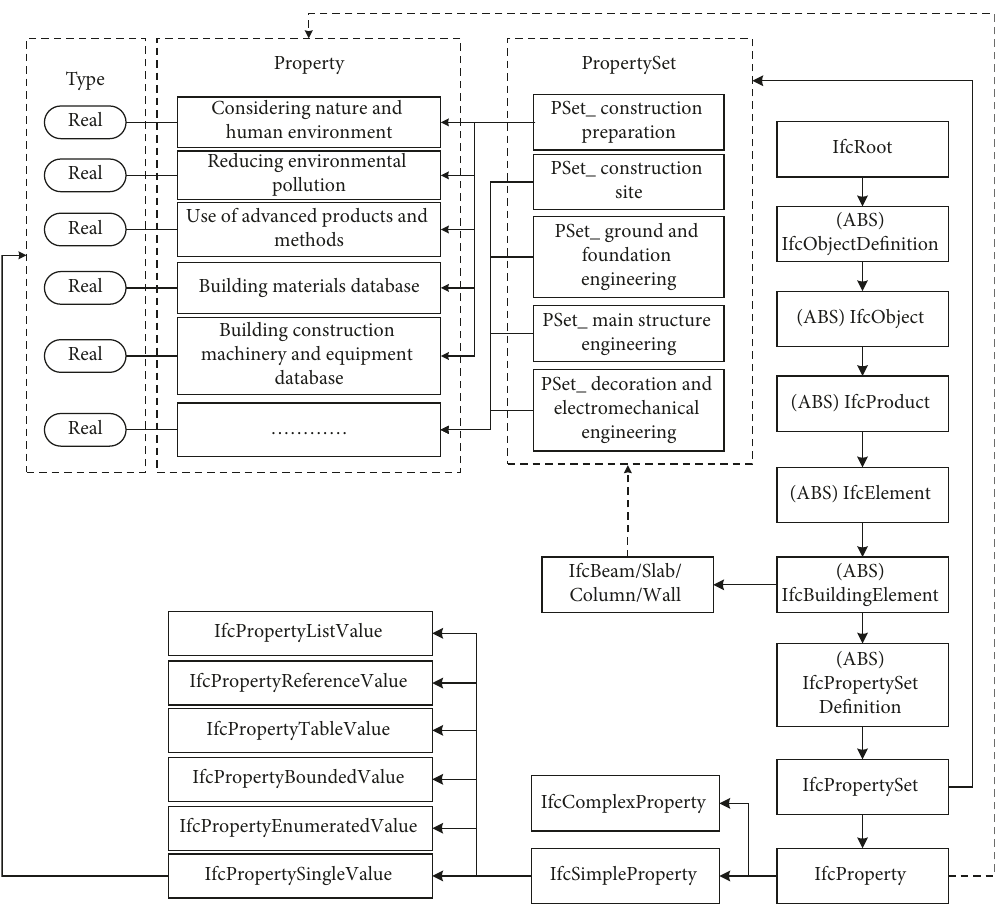
Figure 3: EXPRESS-G chart of the evaluation indicators on green construction.